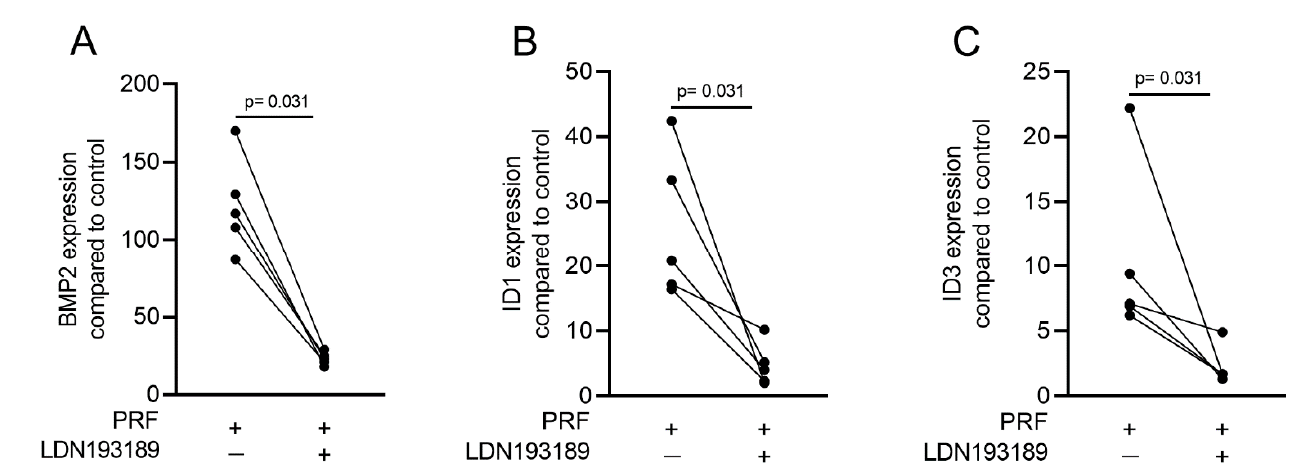
Figure 7. A potent ALK2/3 inhibitor can block BMP2 and ID genes. Gingival fibroblasts were exposed to PRF lysates in the presence or absence of 100 nM LDN193189. PCR analyses for ( A ) BMP2, ( B ) ID1, and ( C ) ID3 gene expression are presented. n = 5. Statistical analysis was performed with the two-tailed t -test.